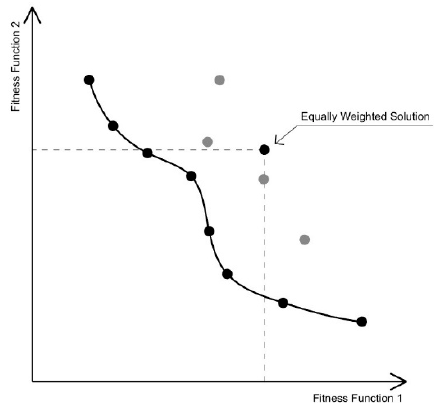
Figure 5. Example of the solution with the most equal weights among the fitness ranks; i.e., the solution with the least trade-offs between fitness functions. This solution may not be located on the pareto front.